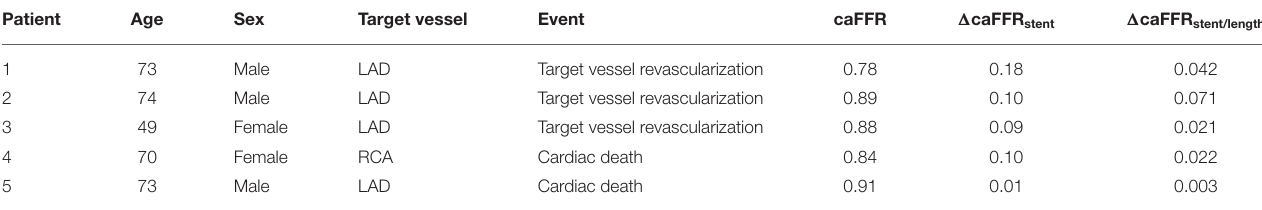
TABLE 5 | Post- percutaneous coronary intervention (PCI) functional assessments of 5 patients with target vessel failure (TVF) during 9-month follow-up time.